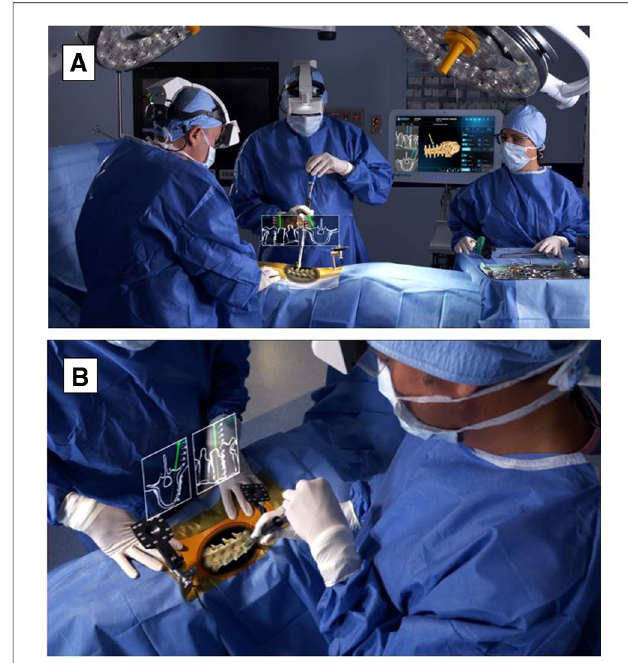
FIGURE 3 ( A ) HMD projects a 3D visualization of the surgeon ’ s retina. ( B ) Surgeon sees a 3D image of the patient ’ s spine with two-dimensional CT images of the instruments ’ path and trajectory while looking directly at the surgical fi eld. HMD. head-mounted display; 3D, three-dimensional; CT, computed tomography. Courtesy of